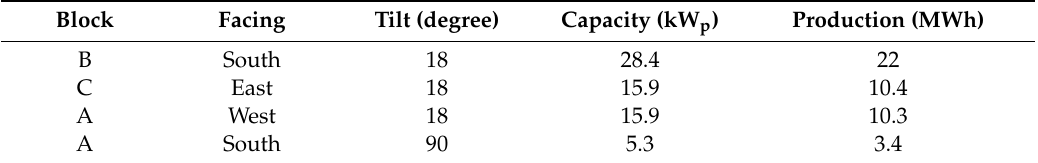
Figure 5. Bird view of the small district in the case study [18]. Table 1. Characteristics of the shared PV system.